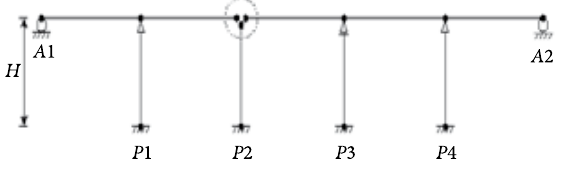
Fig. 5. Finite element model of the selected